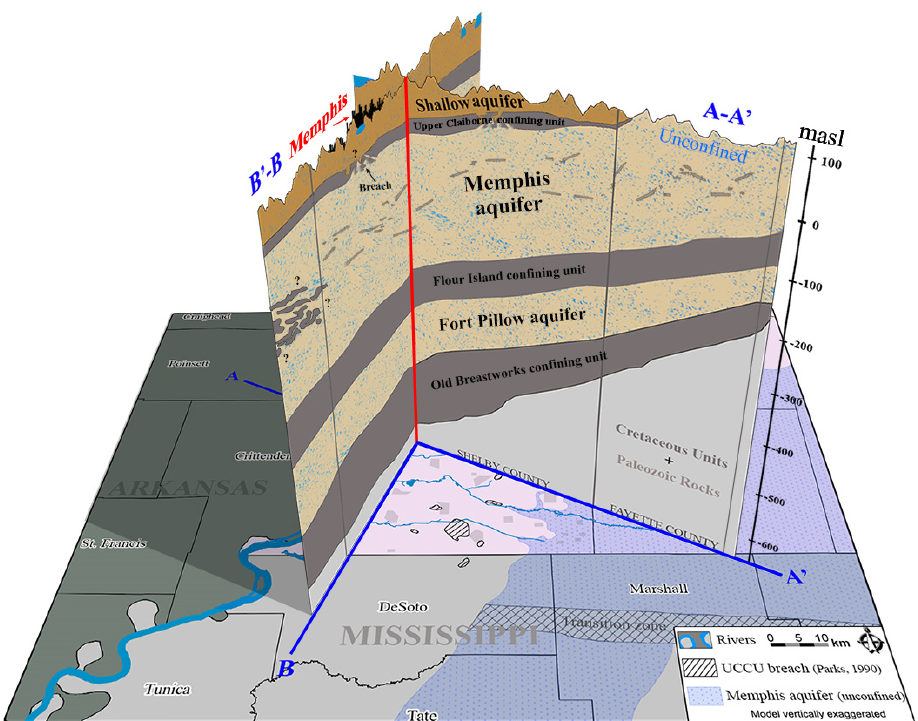
Figure 3. Schematic 3-D cross section showing the hydrogeologic units described in Table 1 that underlie Shelby County, Tennessee from northwest to southeast along line A-A’, and southwest to northeast along line B-B’. Modified from Brahana and Broshears [26] with geologic surfaces from Hart et al. [58].